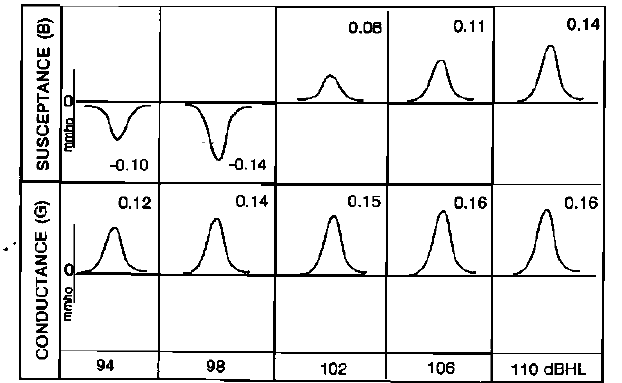
Figure 3. Sketch to show an example of the direc- tion change in susceptance (-B+G;